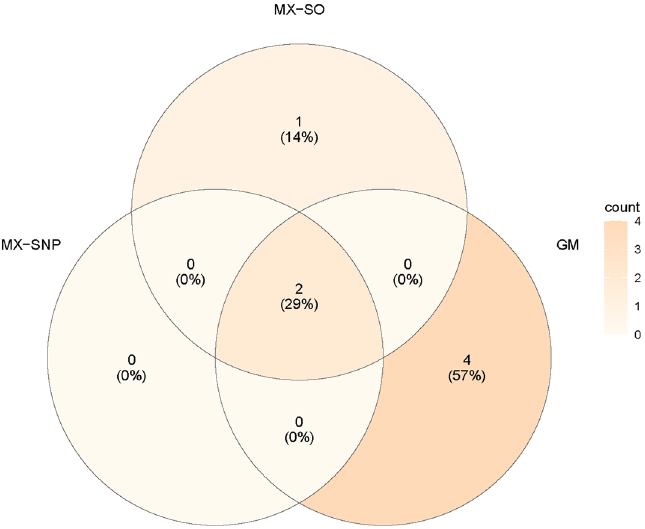
Figure 3. The consistency among AV45-associated genes selected by model-X knockoff models and Gaussian